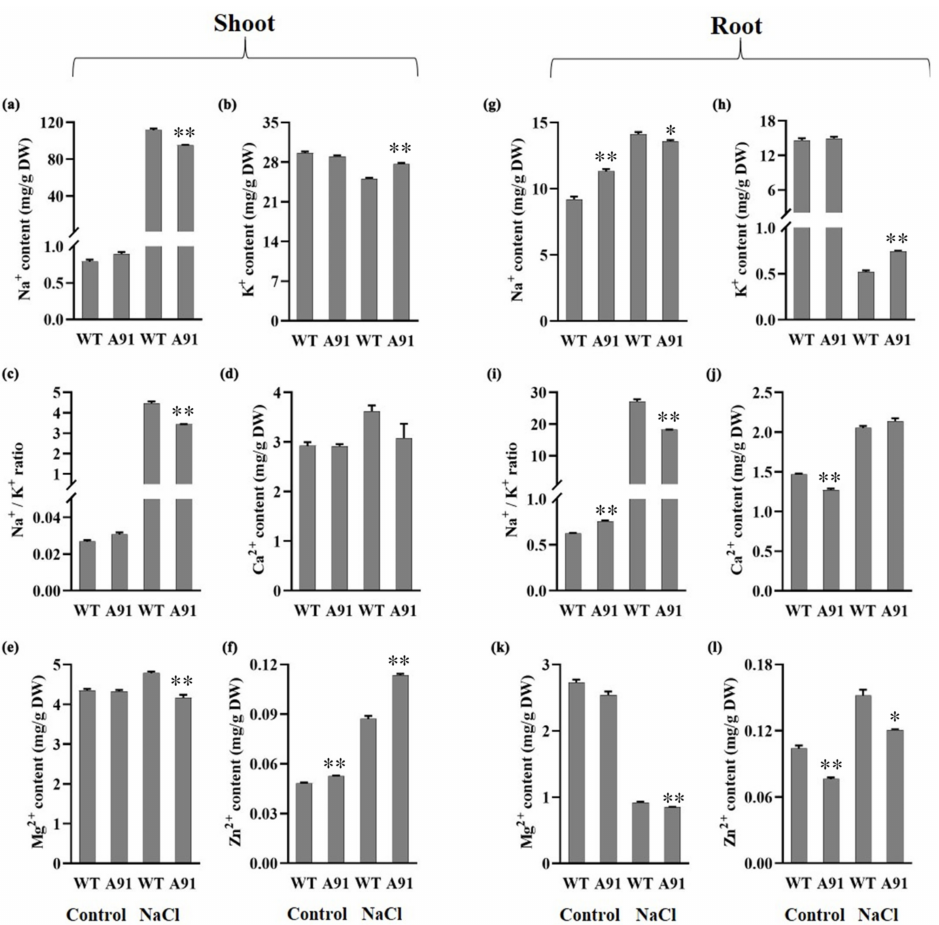
Figure 6. Measurement of nutrient elements in the shoots and roots of WT and A91 seedlings exposed to salt stress for 7 days. ( a – f ) Na + , K + , Na + /K + , Ca 2+ , Mg 2+ , and Zn 2+ in shoots; ( g – l ) Na + , K + , Na + /K + , Ca 2+ , Mg 2+ , and Zn 2+ in roots; n = 3 biological replicates; data represent means ± SE; * and ** indicate significant t -test results at p < 0.05 and p < 0.01,